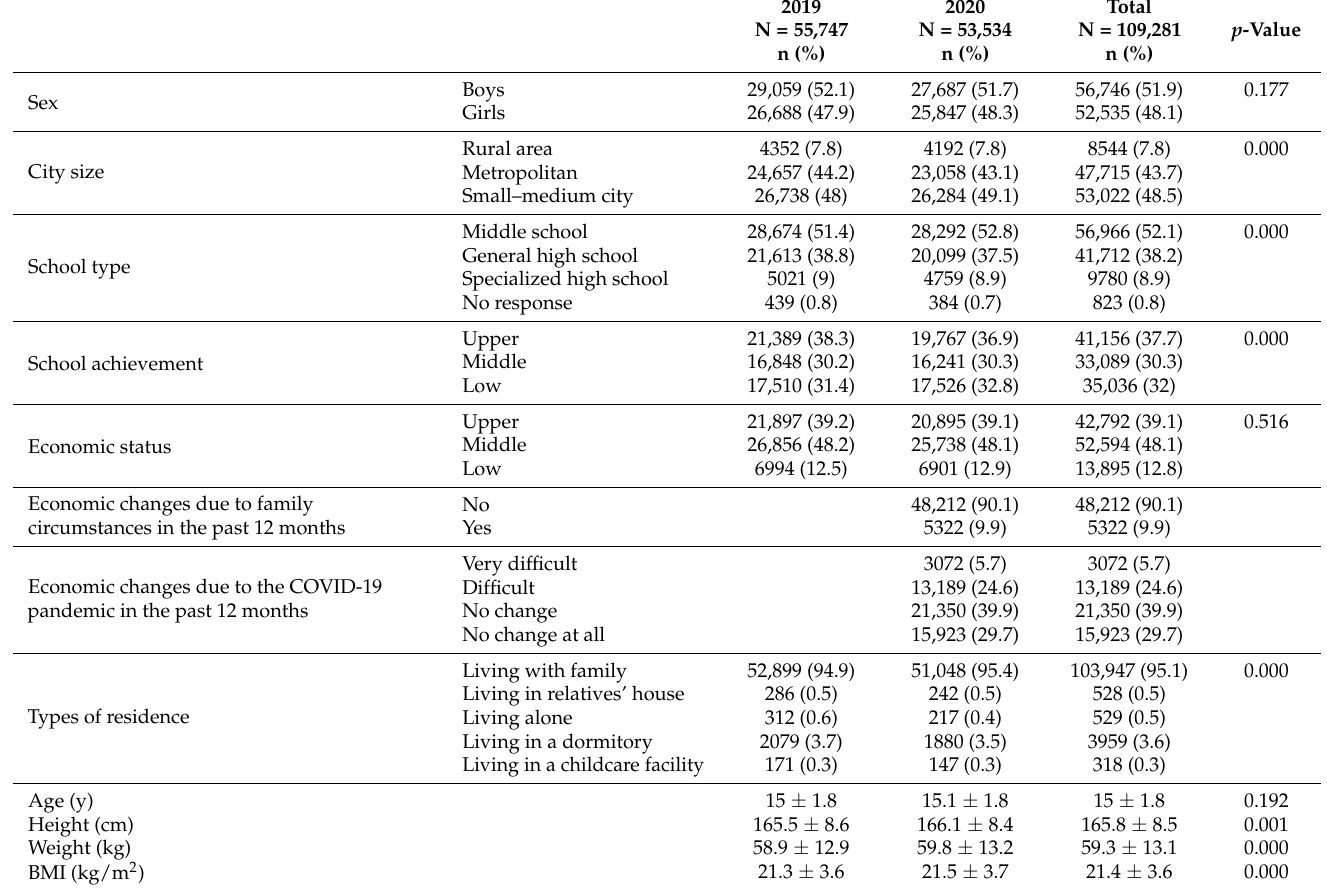
Table 1. Participants’ general